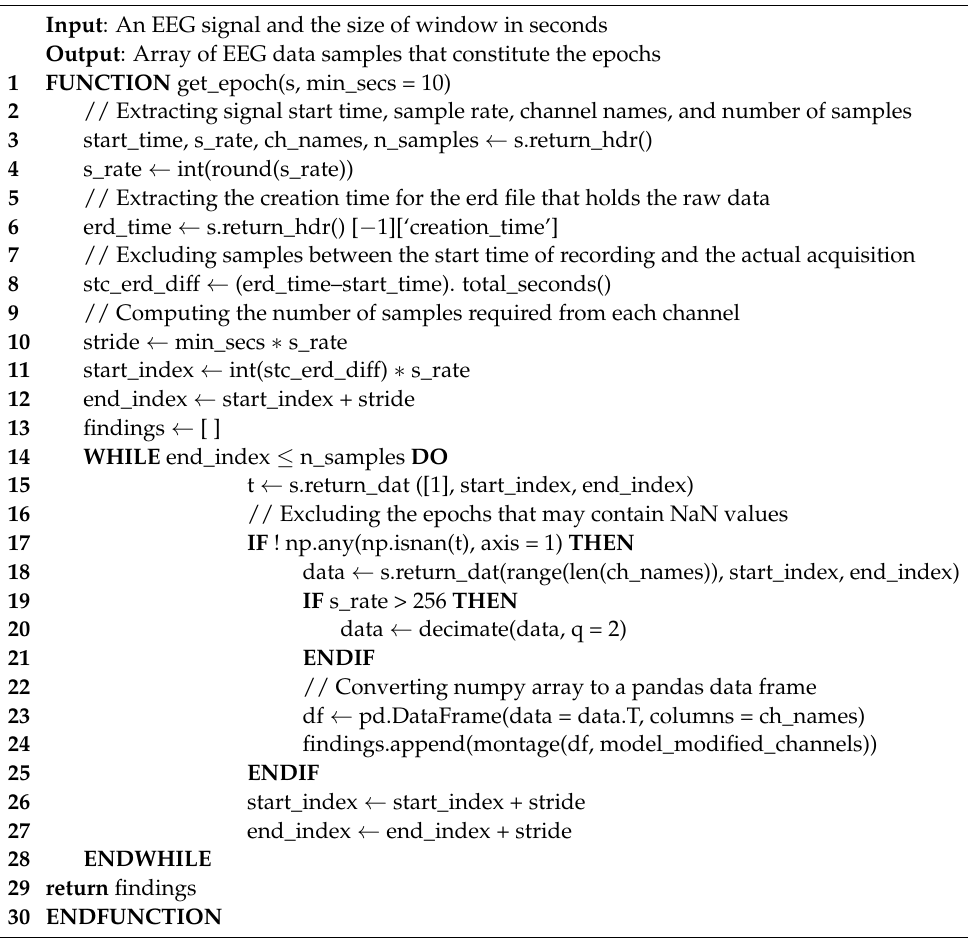
Algorithm 1. R EADING XL TEK EEG D ATA A LGORITHM